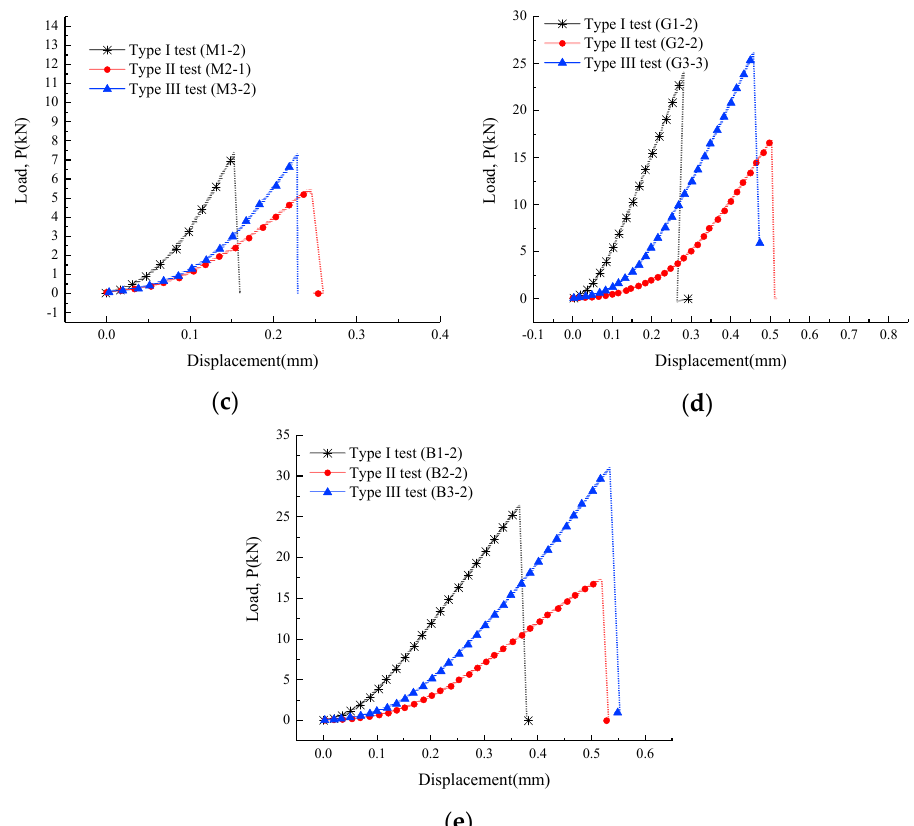
Figure 4. Load–displacement curves of representative specimens of ( a ) WS, ( b ) RS, ( c ) M, ( d ) G and ( e ) B for each loading method (WS, RS, M, G, B represents white sandstone, red sandstone, marble, granite and basalt, respectively).